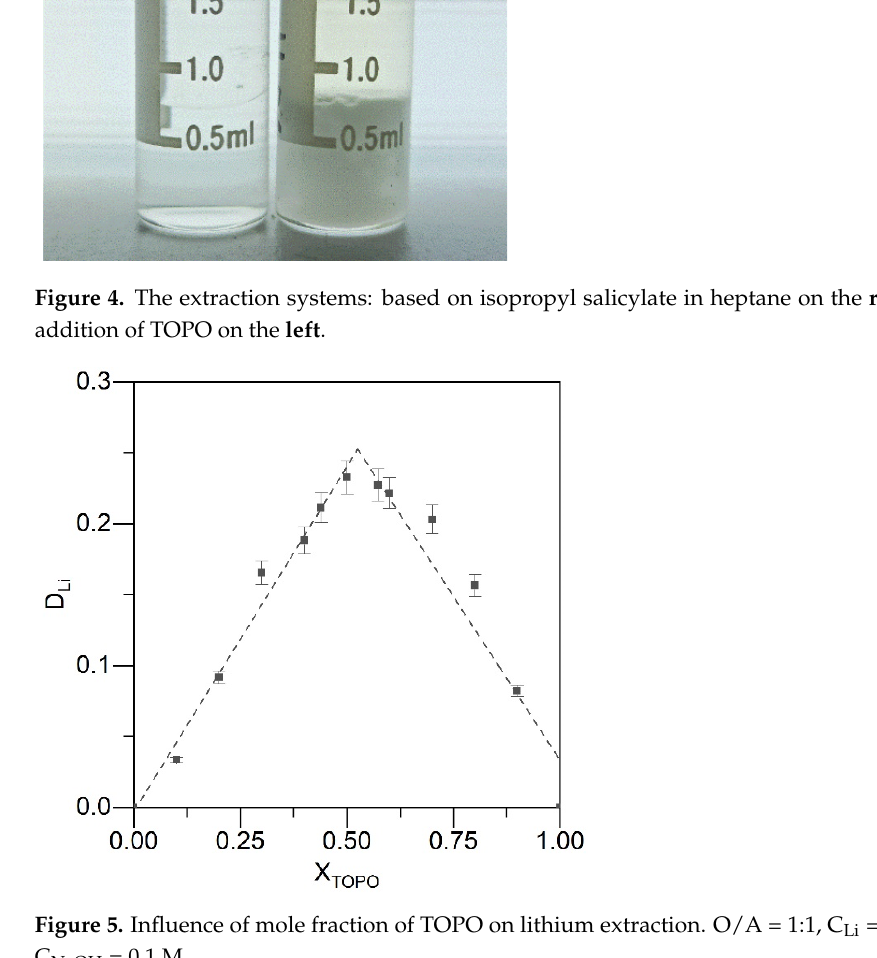
Figure 5. Influence of mole fraction of TOPO on lithium extraction. O/A = 1:1, C Li = 0.02 mol L − 1 , C NaOH = 0.1 M.